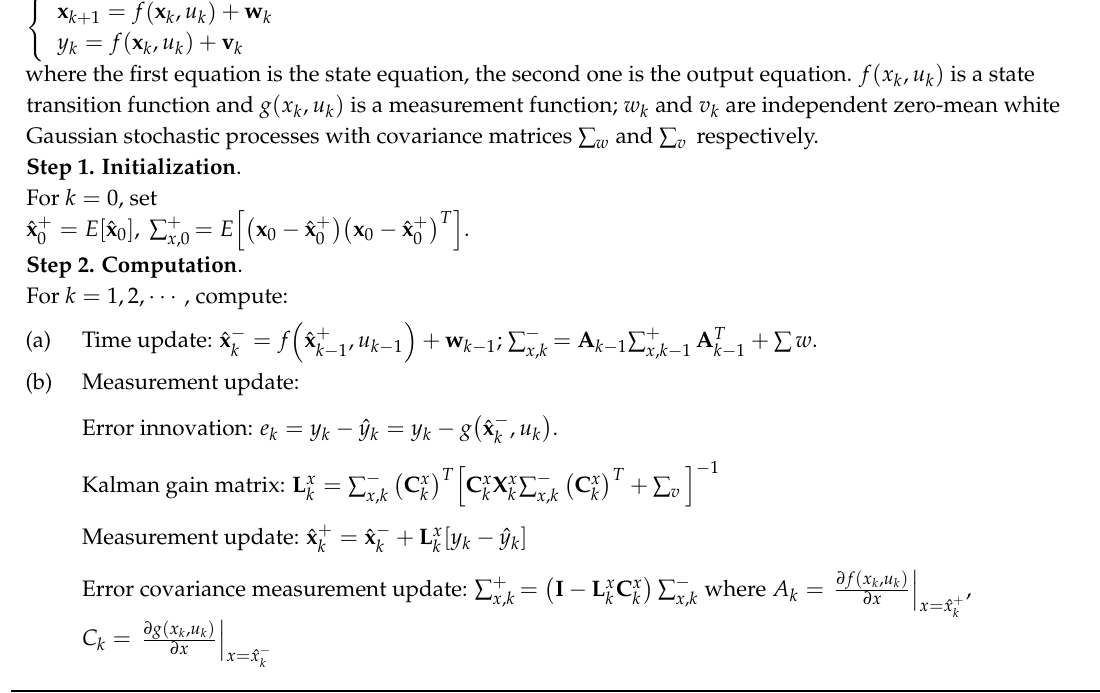
Algorithm 1. Summary of the extended Kalman filter (EKF) method for SOC estimation. The nonlinear state-space model: